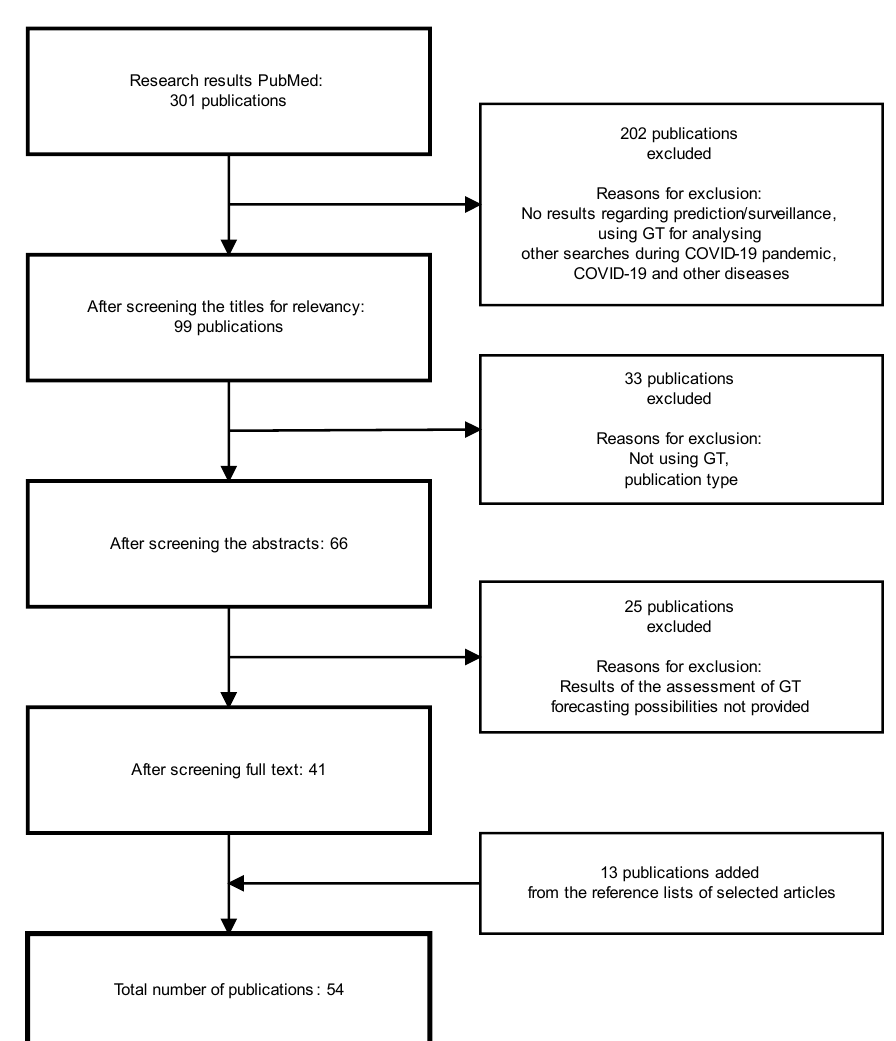
Figure 1. Selection process of the articles to review .